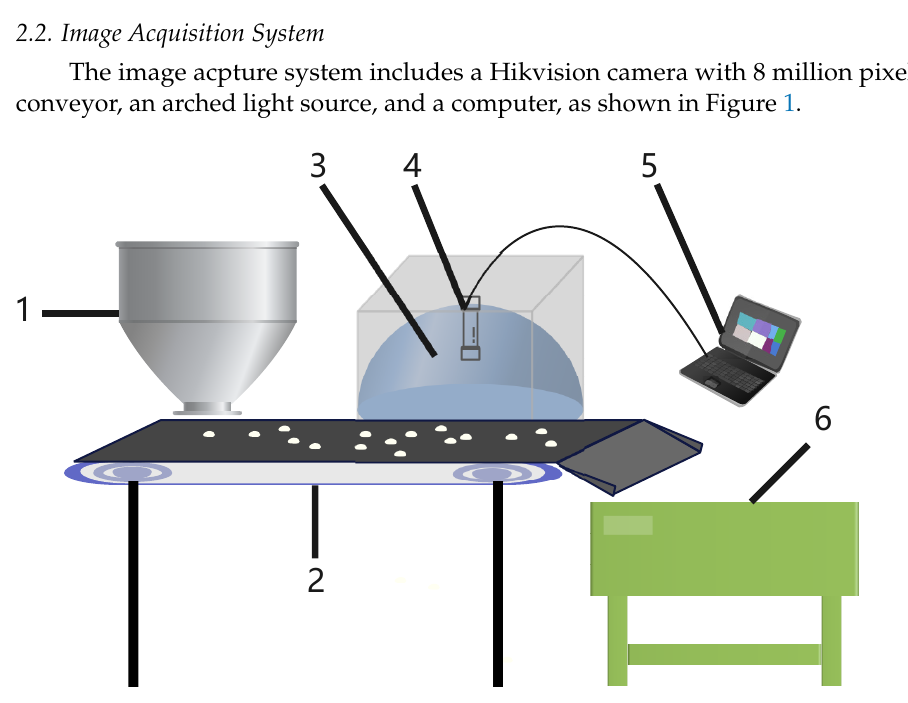
Figure 1. Image acquisition system. 1. Hopper. 2. Transfer device. 3. Arched light source. 4.